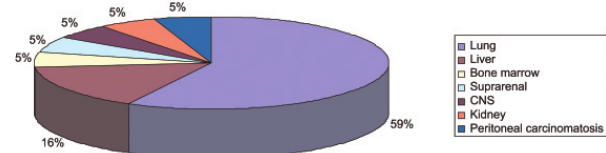
Figure 5- Distribution according to the site of non-bone metastases